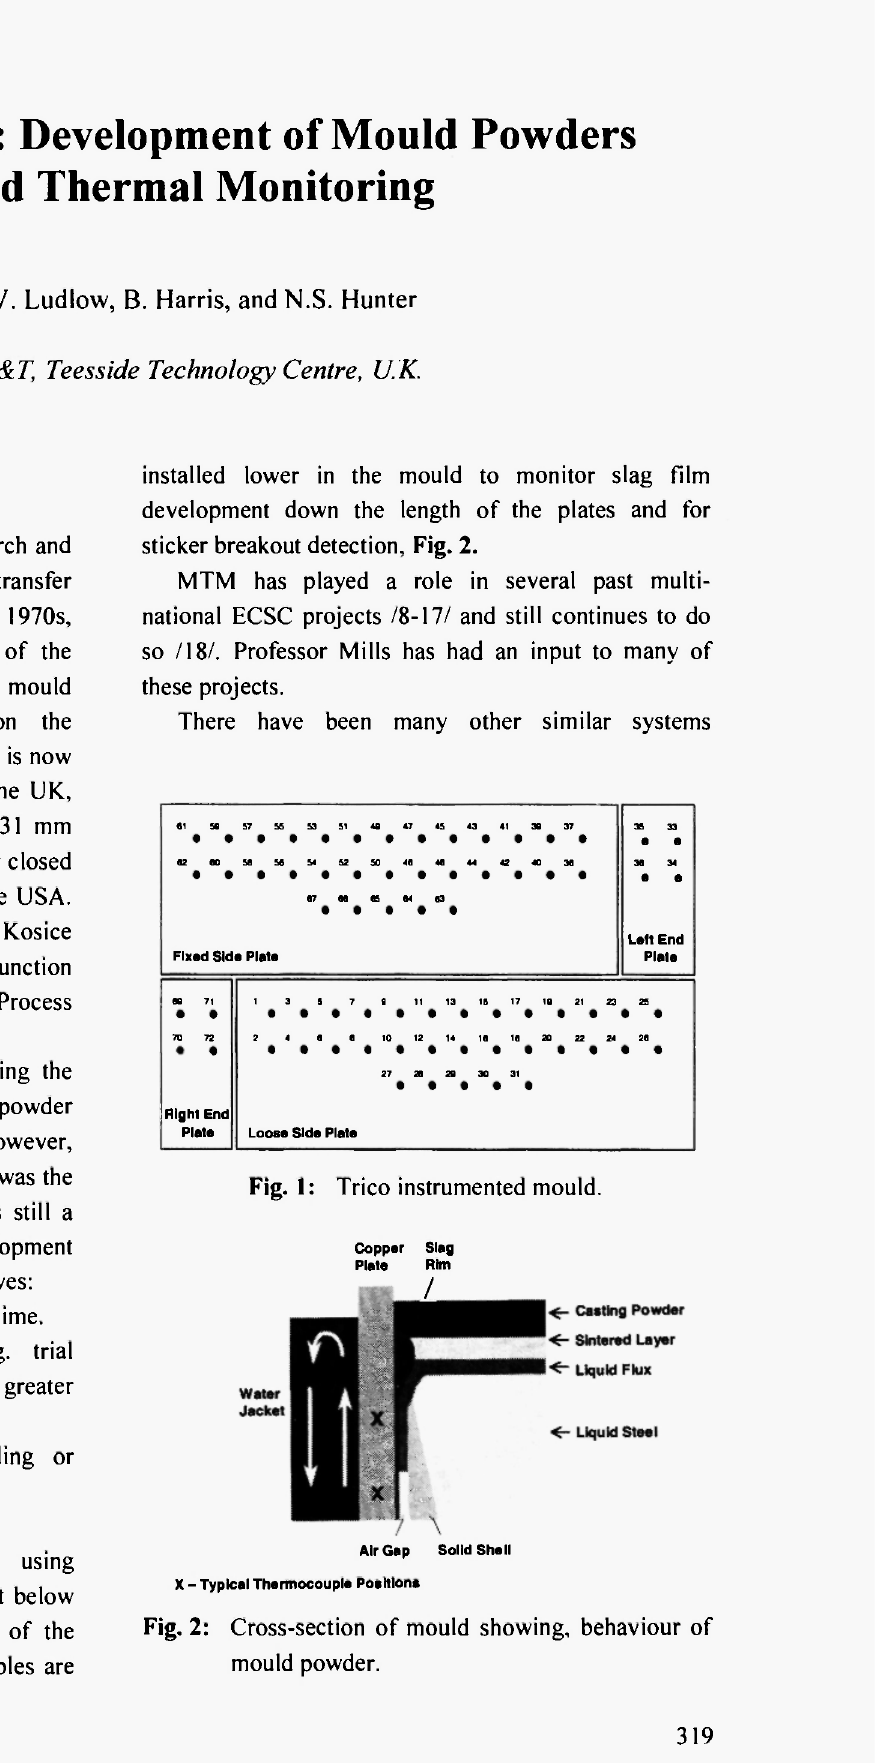
Fig. 2: Cross-section of mould showing, behaviour of mould